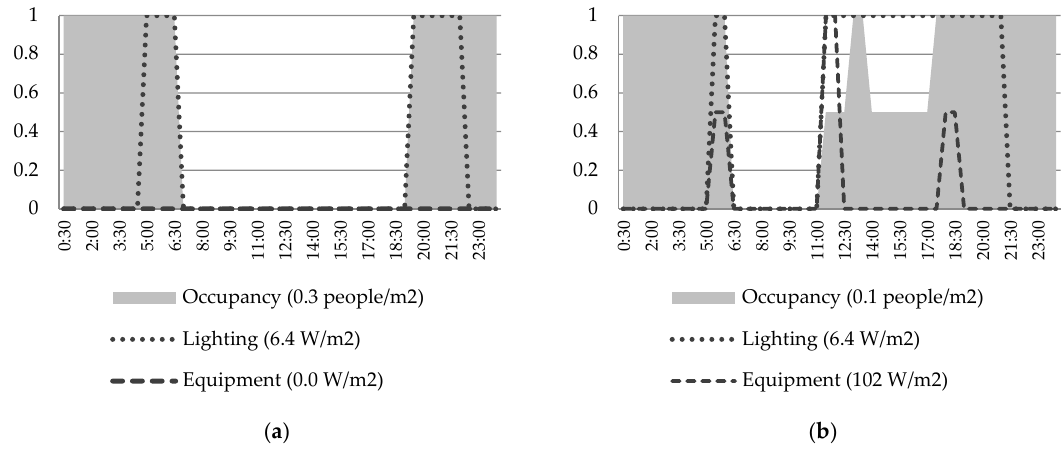
Figure 2. Internal load schedules ( a ) Case A internal loads; and ( b ) Case B internal loads.